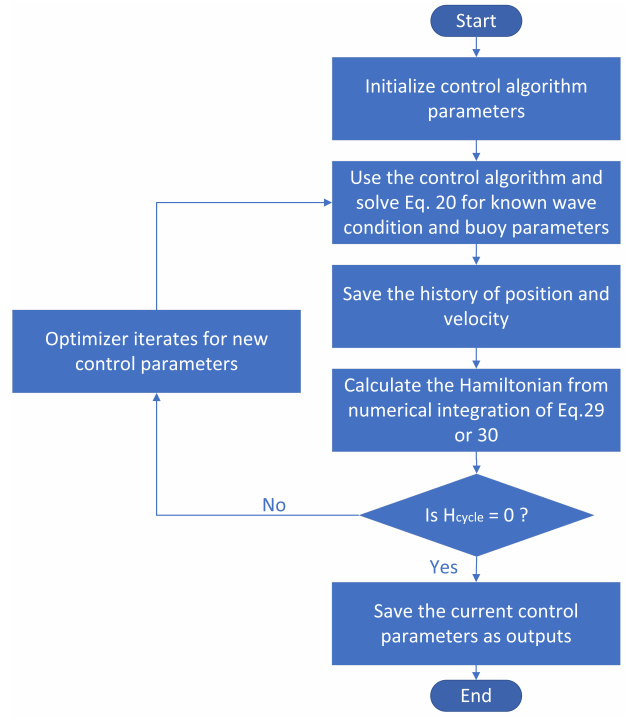
Figure 2. The design process for the Hamiltonian Surface-Shaping (HSS)